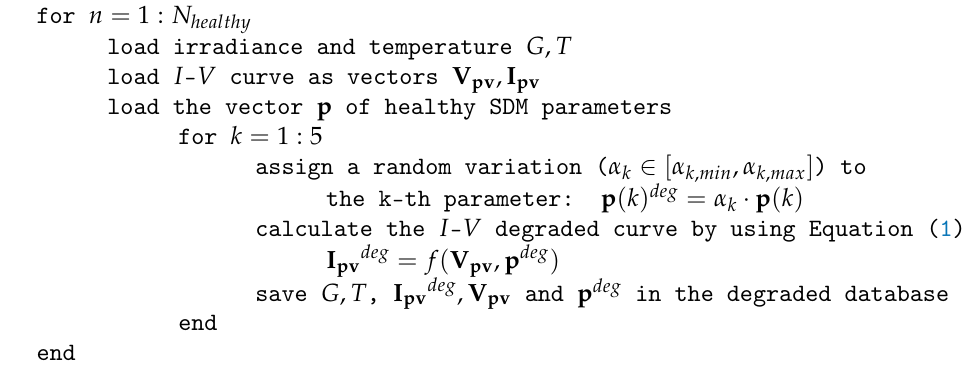
Table 3. Pseudo code for generating degraded I - V curves. for n = 1 : N